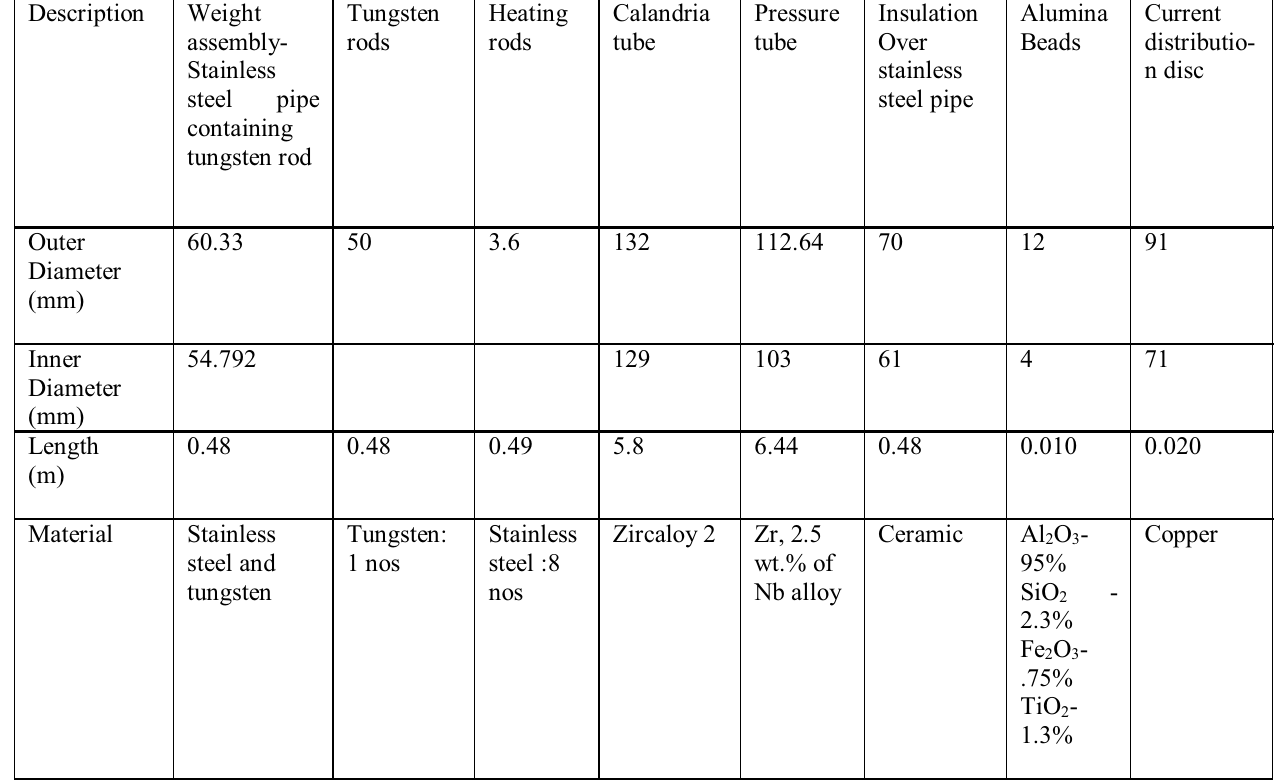
Table I : Specification of experimental test set